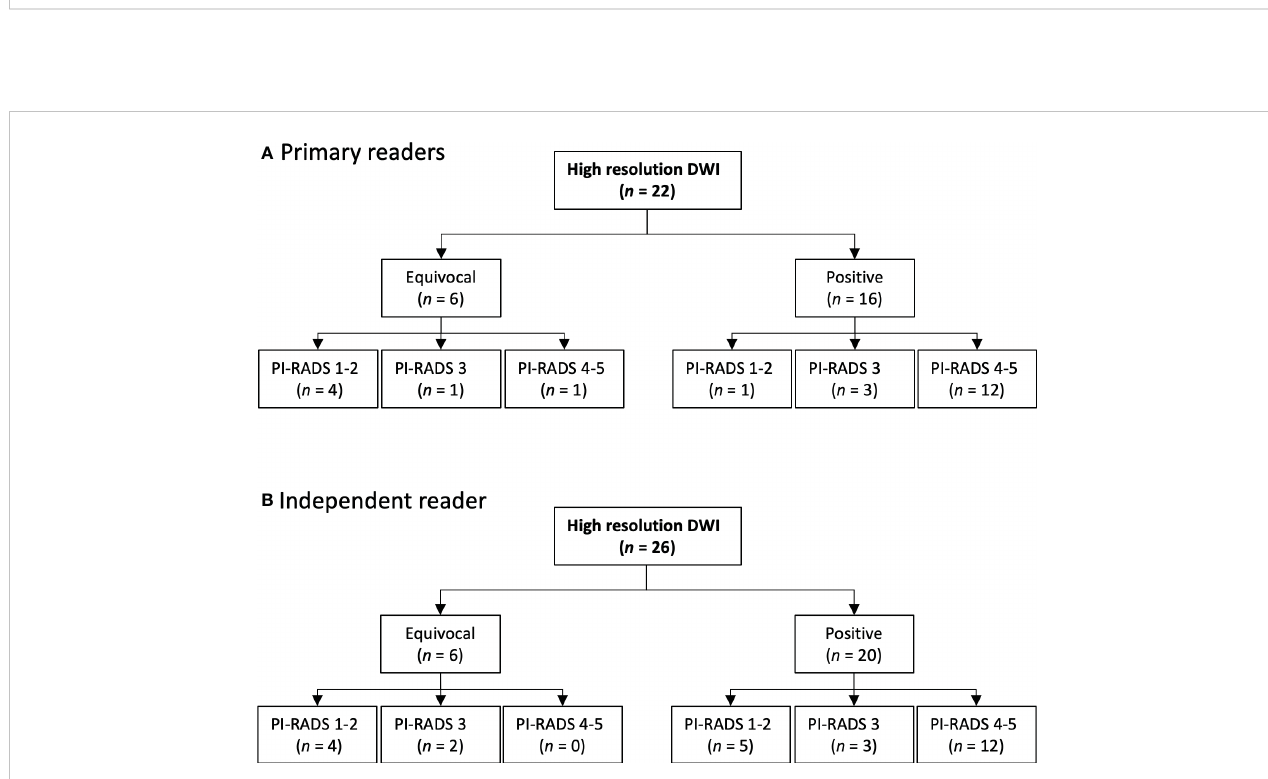
FIGURE 7 Transitional zone fi ndings: Comparison of the primary and the independent readings of high-resolution